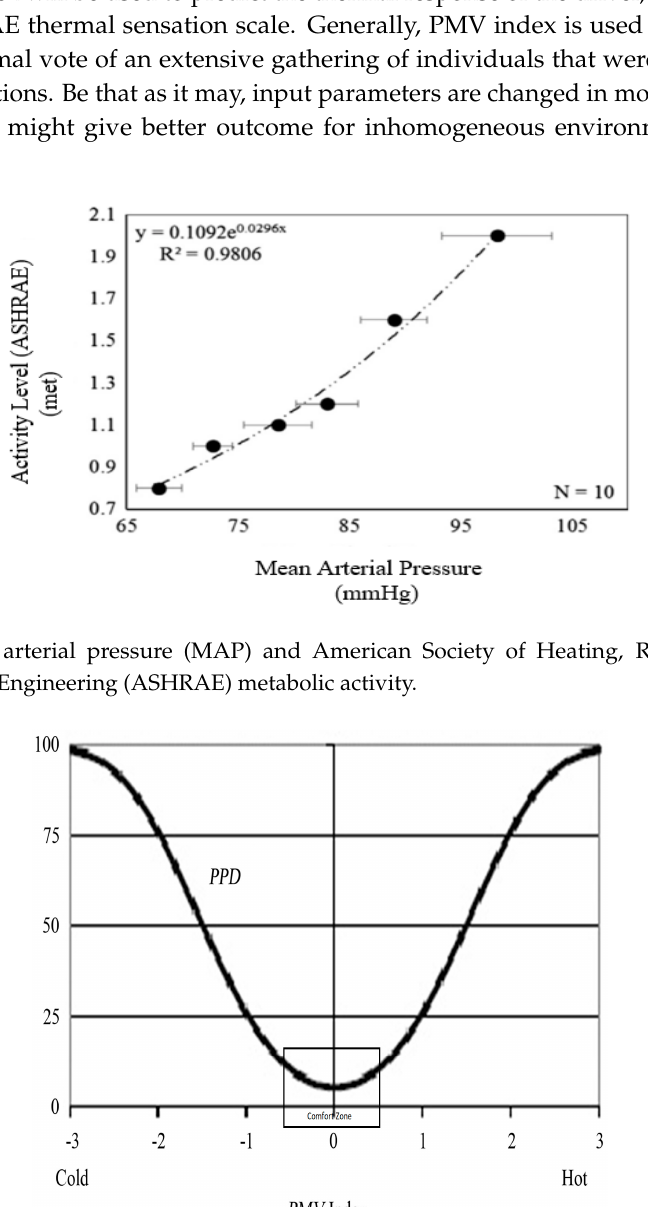
Figure 3. Predicted percentage dissatisfaction (PPD) as a function of predicted mean vote (PMV).